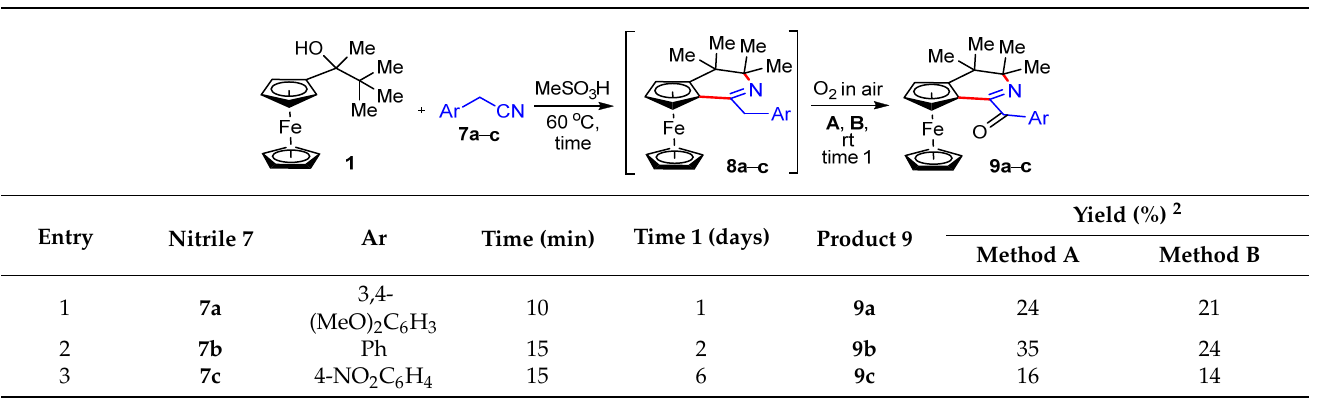
Table 3. Reaction of alcohol 1 with phenylacetonitriles 7a – c 1 .